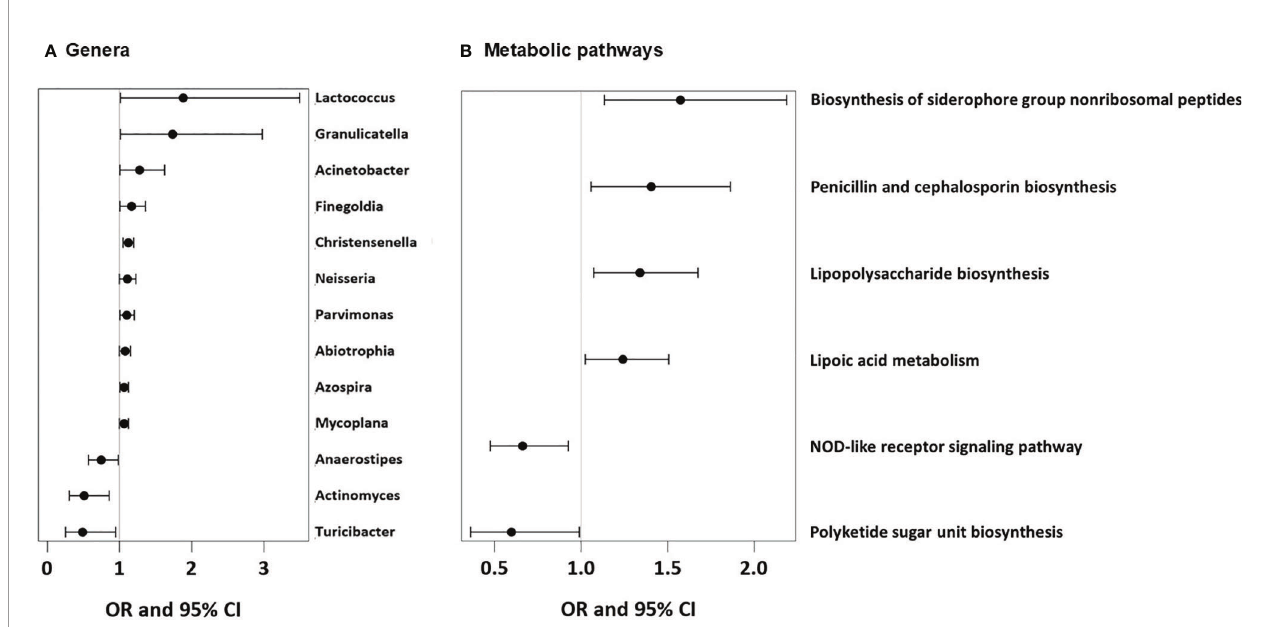
FIGURE 12 | Microbial genera and microbial metabolic pathways associated with UMC. (A) Odds ratios (OR) with 95%-con fi dence intervals for the associations of UMC with relative abundance of bacterial genera in fecal samples. (B) Odds ratios (OR) with 95%-con fi dence intervals for the associations of UMC with relative abundance of metabolic pathways in fecal samples.